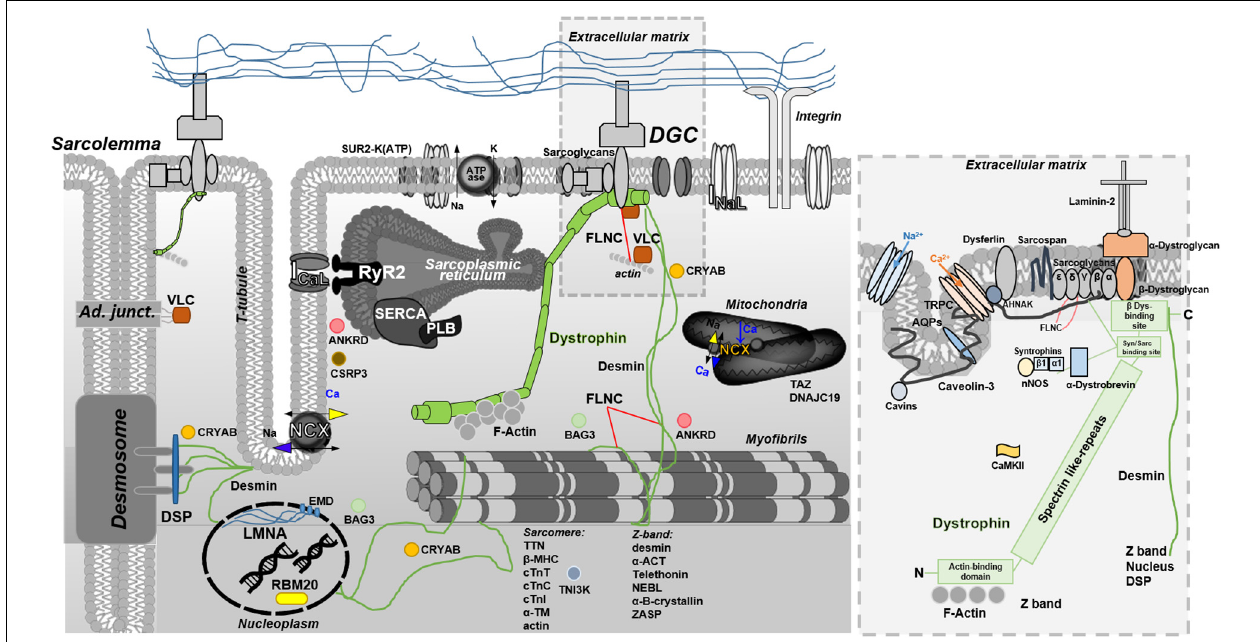
FIGURE 2 | Overview of full-length dystrophin in the context of other DCM-related proteins. The blow-up box, is a focus on full-length dystrophin structure and interactions. Full-length dystrophin is a large rod-shaped protein with a molecular weight of 427 kDa composed by 4 structural domains. The amino (N)-terminal domain has homology with α -actinin and binds, in particular, the F-actin; the central rod-domain contains 24–25 spectrin-like repeats the cysteine-rich domain intereacting with syntrophin and sarcoglycans; the last carboxy (C)-terminal domain associates at the C-terminal with β -dystroglican and several other proteins to form a major protein complex referred to as the dystrophin glycoproteic complex (DGC) (Hoffman et al., 1987; Ervasti and Campbell, 1993). The DGC consists of α - and β -dystroglycan subunits, α -, β -, δ -, γ -, and ε -sarcoglycans, sarcospan, α - and β -syntrophins, α -dystrobrevin, and neuronal nitric oxide synthase (nNOS) (Mosqueira et al., 2013). DGC related-pathways include Ca 2 + homeostasis and E-C coupling, mitochondrial function, motor protein interaction (sarcomere/Z-band), and gene expression. For instance, the acetylcholine receptor, the skeletal and cardiac isoforms of the voltage-gated sodium channels (Nav1.4 and Nav1.5, respectively), the L-type Ca 2 + channel, aquaporin, and stretch-activated channel or transient receptor potential (TRP) cation channels (Shirokova and Niggli, 2013) are closely associated with the DGC via syntrophins. In the cardiac tissue, dystrophin is also associated to: Cavin-1 and Caveolin-3 (responsible for caveolae/T tubule formation), Ahnak1 (modulates L-type Ca 2 + channel), CryAB (involved in cytoprotection and antiapoptosis), and Cipher (plays a role in muscle contraction maintaining the Z-line integrity and signaling). Dystrophin can be also target of phosphorylation by Calmodulin-dependent kinase II (CaMKII) that modulates